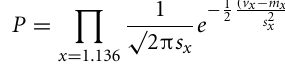
ULTRAFAST UNSUPERVISED BINNING BASED ON TETRANUCLEOTIDE